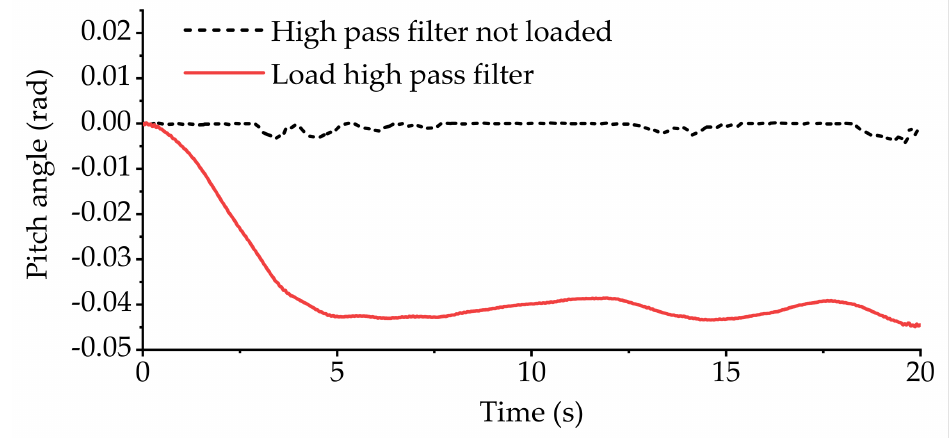
Figure 18. Pitch angle of vehicle body in longitudinal slope experiment.